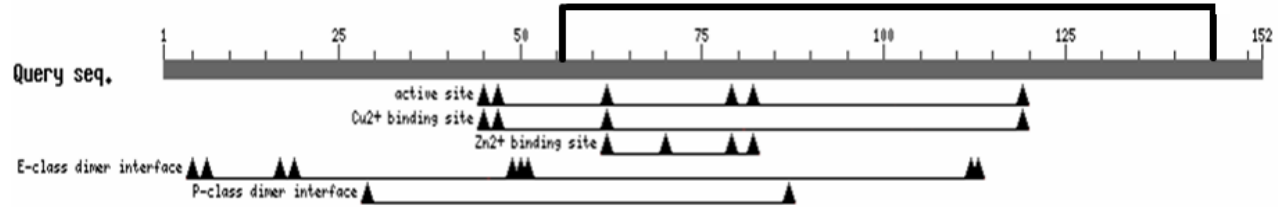
Figure 1. Nucleotide and deduce amino acid sequences of PS-CuZnSOD cDNA from P. sibiricum Laxm. The PCR products of PS-CuZnSOD cDNA were sequenced. The full length was 669 bp, with a 5' untranslated region of 87 bp, a 3' untranslated region of 123 bp and an open reading frame (ORF) encoding 152 amino acid (459 bp). The cDNA sequence of PS-CuZnSOD has been submitted to GenBank (accession No. GQ472846). The rectangle indicates the active site of the PS-CuZnSOD ; ellipse indicates the Cu 2+ binding site; * indicates the Zn 2+ binding site; # indicates the stop codon. Two conserved CuZnSOD signatures are shown in broken line. The signal peptide is shown in solid line. Two cysteines (Cys56 and Cys145) form a disulfide bond for this